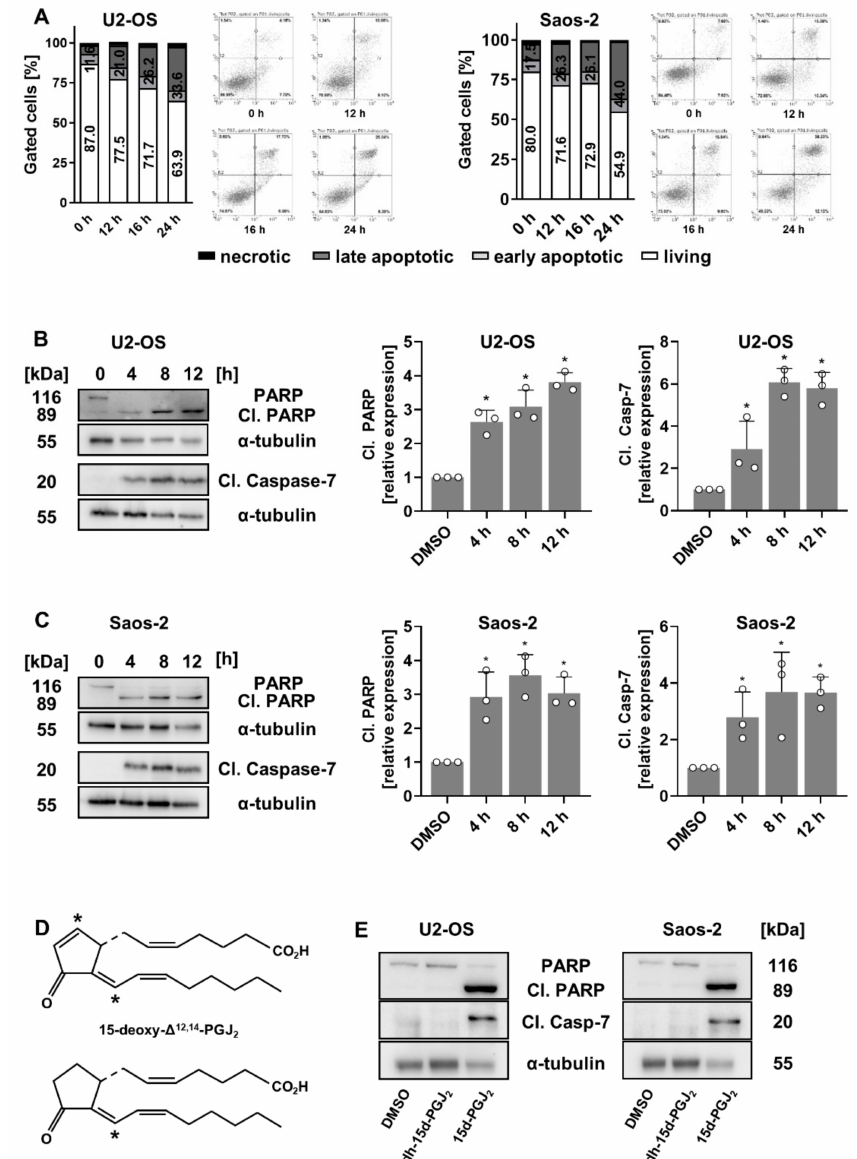
Figure 3. Induction of apoptosis in 15d-PGJ 2 -treated OS cell lines. ( A ) Following treatment of U2-OS ( left panel) and Saos-2 cells ( right panel) with 20 µ M 15d-PGJ 2 for indicated time periods, OS cells were double-stained for Annexin V/PI and analyzed by FACS. Results are displayed in bar graphs and scatter plots for both OS cell lines. Numbers indicate percentage of viable cells (white bars) and cells in early and late apoptosis (sum of both light and dark gray bars) compared to all gated cells set to 100%. One representative scatter plot from three independent experiments, each performed in triplicates, is shown. ( B , C ) U2-OS ( B ) and Saos-2 cells ( C ) were treated with 15d-PGJ 2 for indicated time periods. Afterwards, cells were harvested, lysed and the expression of cleaved PARP (Cl. PARP) and cleaved pro-caspase-7 (Cl. Caspase-7) was assessed from total protein lysates by immunoblotting. One representative blot with corresponding densitometric evaluation based on at least three blots are shown. Alpha-tubulin ( α -tubulin) was used as a loading control. The data are compared to time point zero and represented as means ± SD. (* p ≤ 0.05) ( D ) Structural formula of 15d-PGJ 2 and 9,10-dh-15d-PGJ 2 , the structural analogue lacking the electrophilic carbon atom C9. ( E ) U2-OS ( left panel) and Saos-2 OS cells ( right panel) were treated with 20 µ M 15d-PGJ 2 or 9,10-dh-15d-PGJ 2 for 18 h and apoptosis markers (Cl. PARP and Cl. pro-caspase-7) were analyzed by immunoblotting. One representative blot out of three is shown. Alpha-tubulin ( α -tubulin) was used as a loading